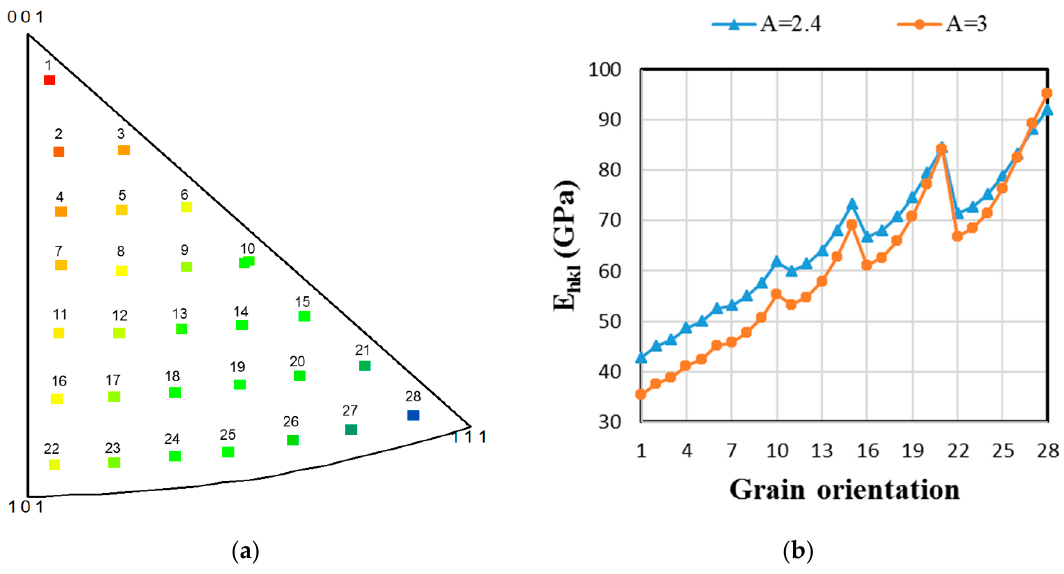
Figure 1. ( a ) Inverse pole figure representing the 2016 grains with random texture decomposed into 28 fiber components with respect to the tensile axis; ( b ) Directional Young’s moduli of single crystals with orientations 1 to 28 parallel to the tensile axis obtained from both considered β -phase single-crystal elastic constants (SEC) (A = 2.4 (triangles) and A = 3 (circles)).